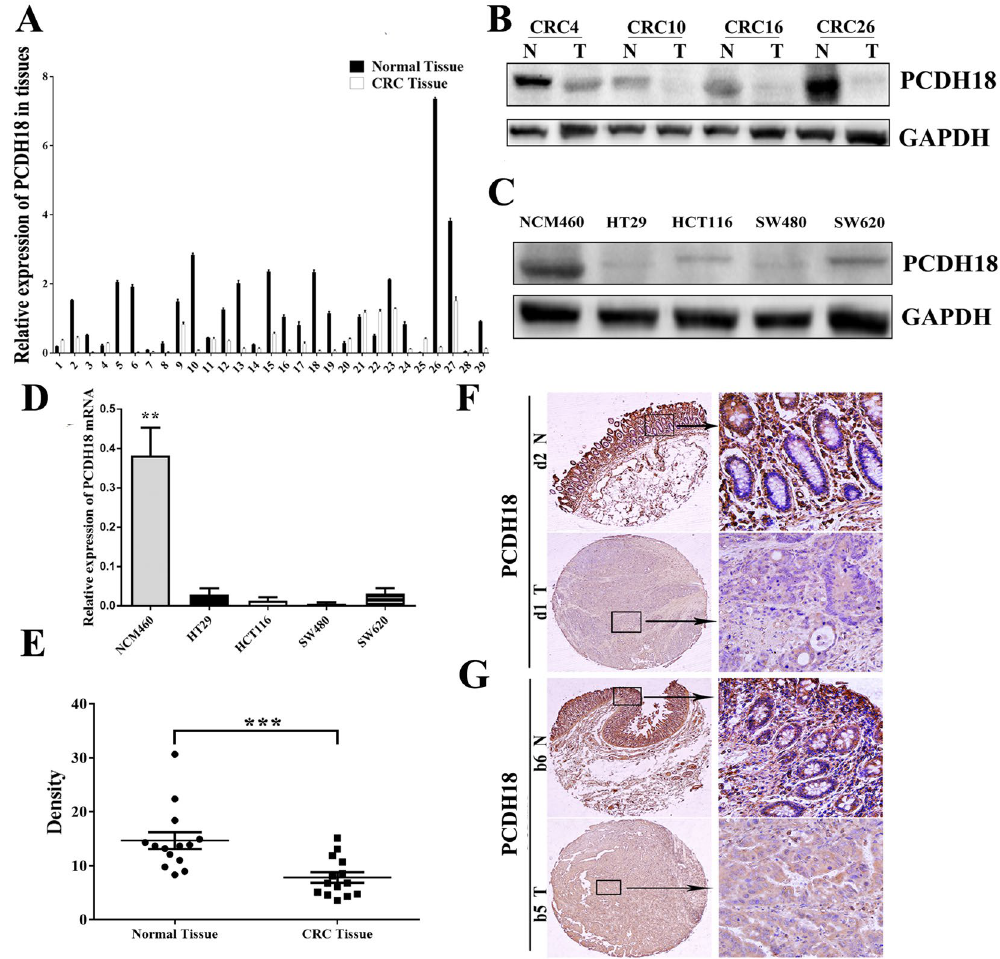
Figure 2. PCDH18 was epigenetically silenced in colorectal cancer tissues and cell lines. ( A ) PCDH18 mRNA expression levels in 29 paired CRC tissues and paired normal tissues were detected using quantitative PCR (qPCR), relative to the value of GAPDH in each sample. ( B ) ROC curves showed the performance of PCDH18 expression levels from CRC tissues in predicting CRC. ( C ) Representative Western blot image for protein expression level of PCDH18 in CRC tissues and paired normal tissues. ( D ) Western blot image for protein expression level of PCDH18 in CRC cell lines (HT29, HCT116, SW480 and SW620) and normal colonic NCM460 cells. ( E ) PCDH18 mRNA expression levels in CRC cell lines (HT29, HCT116, SW480 and SW620) and normal colorectal epithelial NCM460 cells were detected using qPCR, relative to the value of GAPDH in each sample. ( F ) Representative images of PCDH18 staining in CRC tissues and paired normal tissues. Normal tissues showed strong positive staining, whereas CRC tissue displayed weak staining. The right panel (magnification x400) was magnification of where inset in the left tissue array (magnification x100). ( G ) A statistically significant difference was detected between the mean density of CRC tissues and that of paired normal tissues in tissue microarray. Results were shown with means ± SD. ** p < 0.01 *** p <